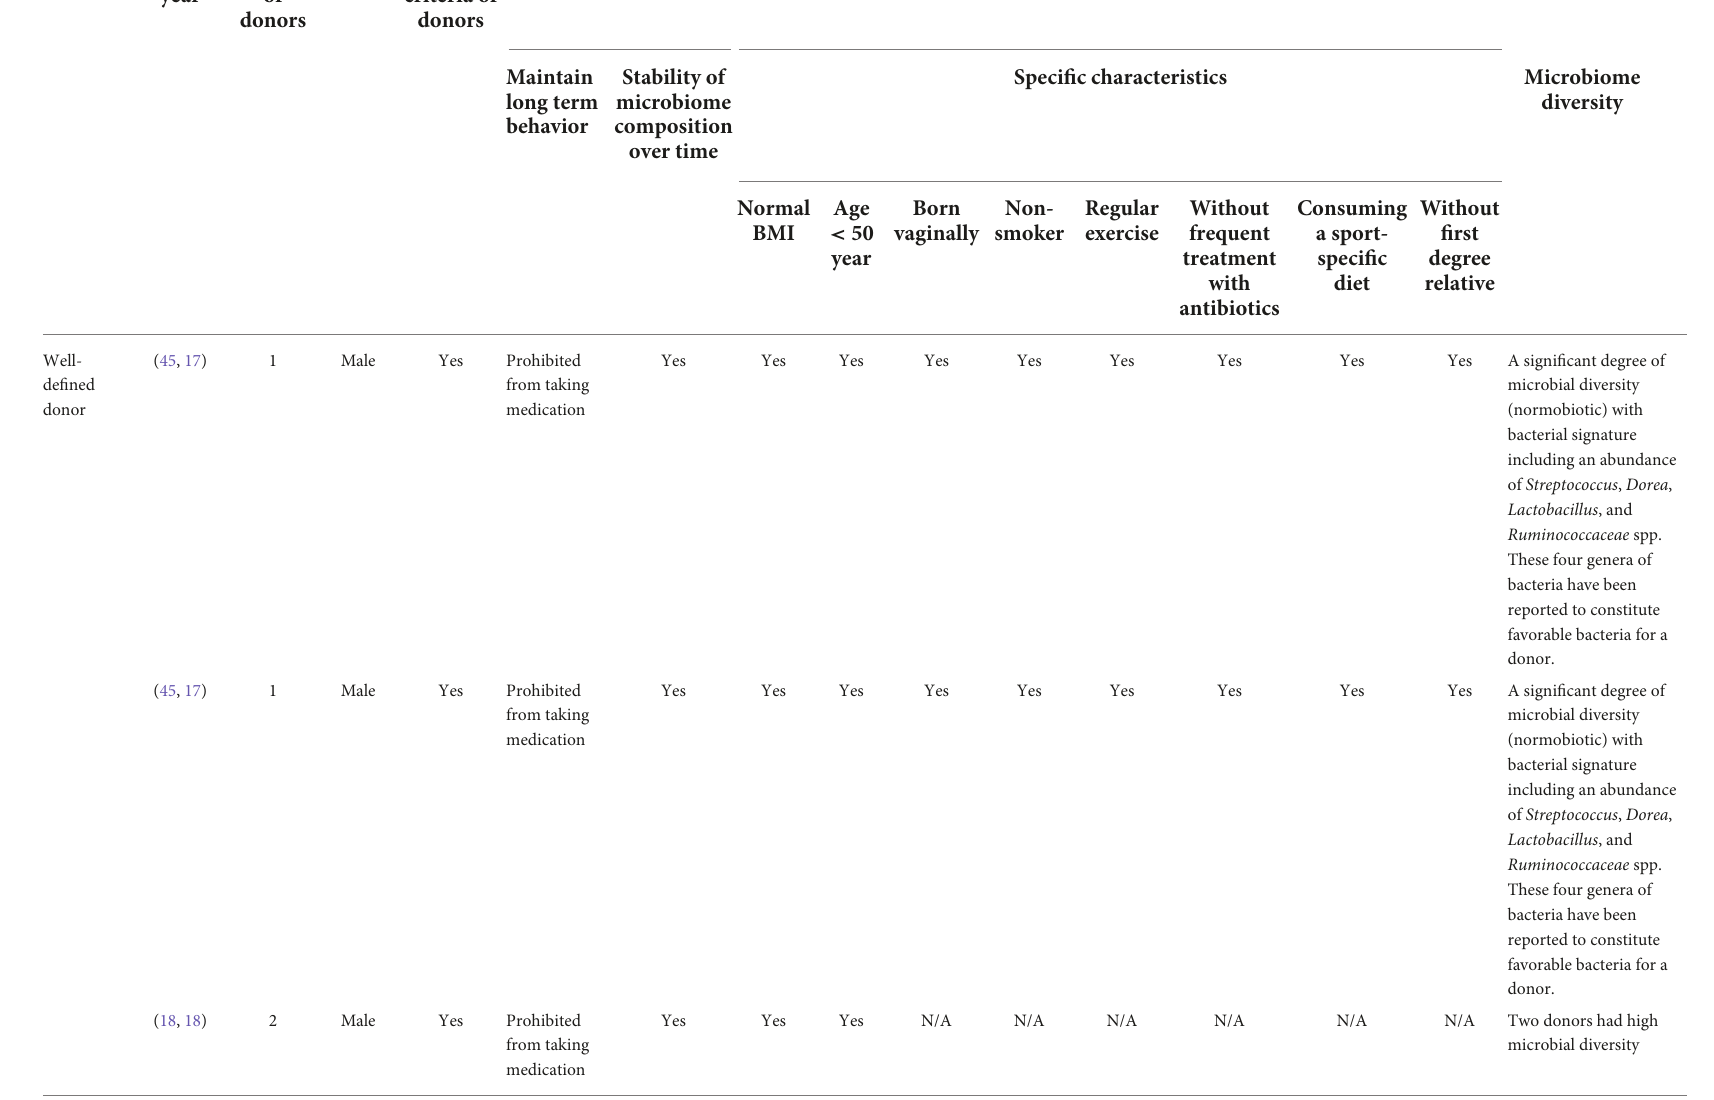
TABLE 3 The characteristics of stool